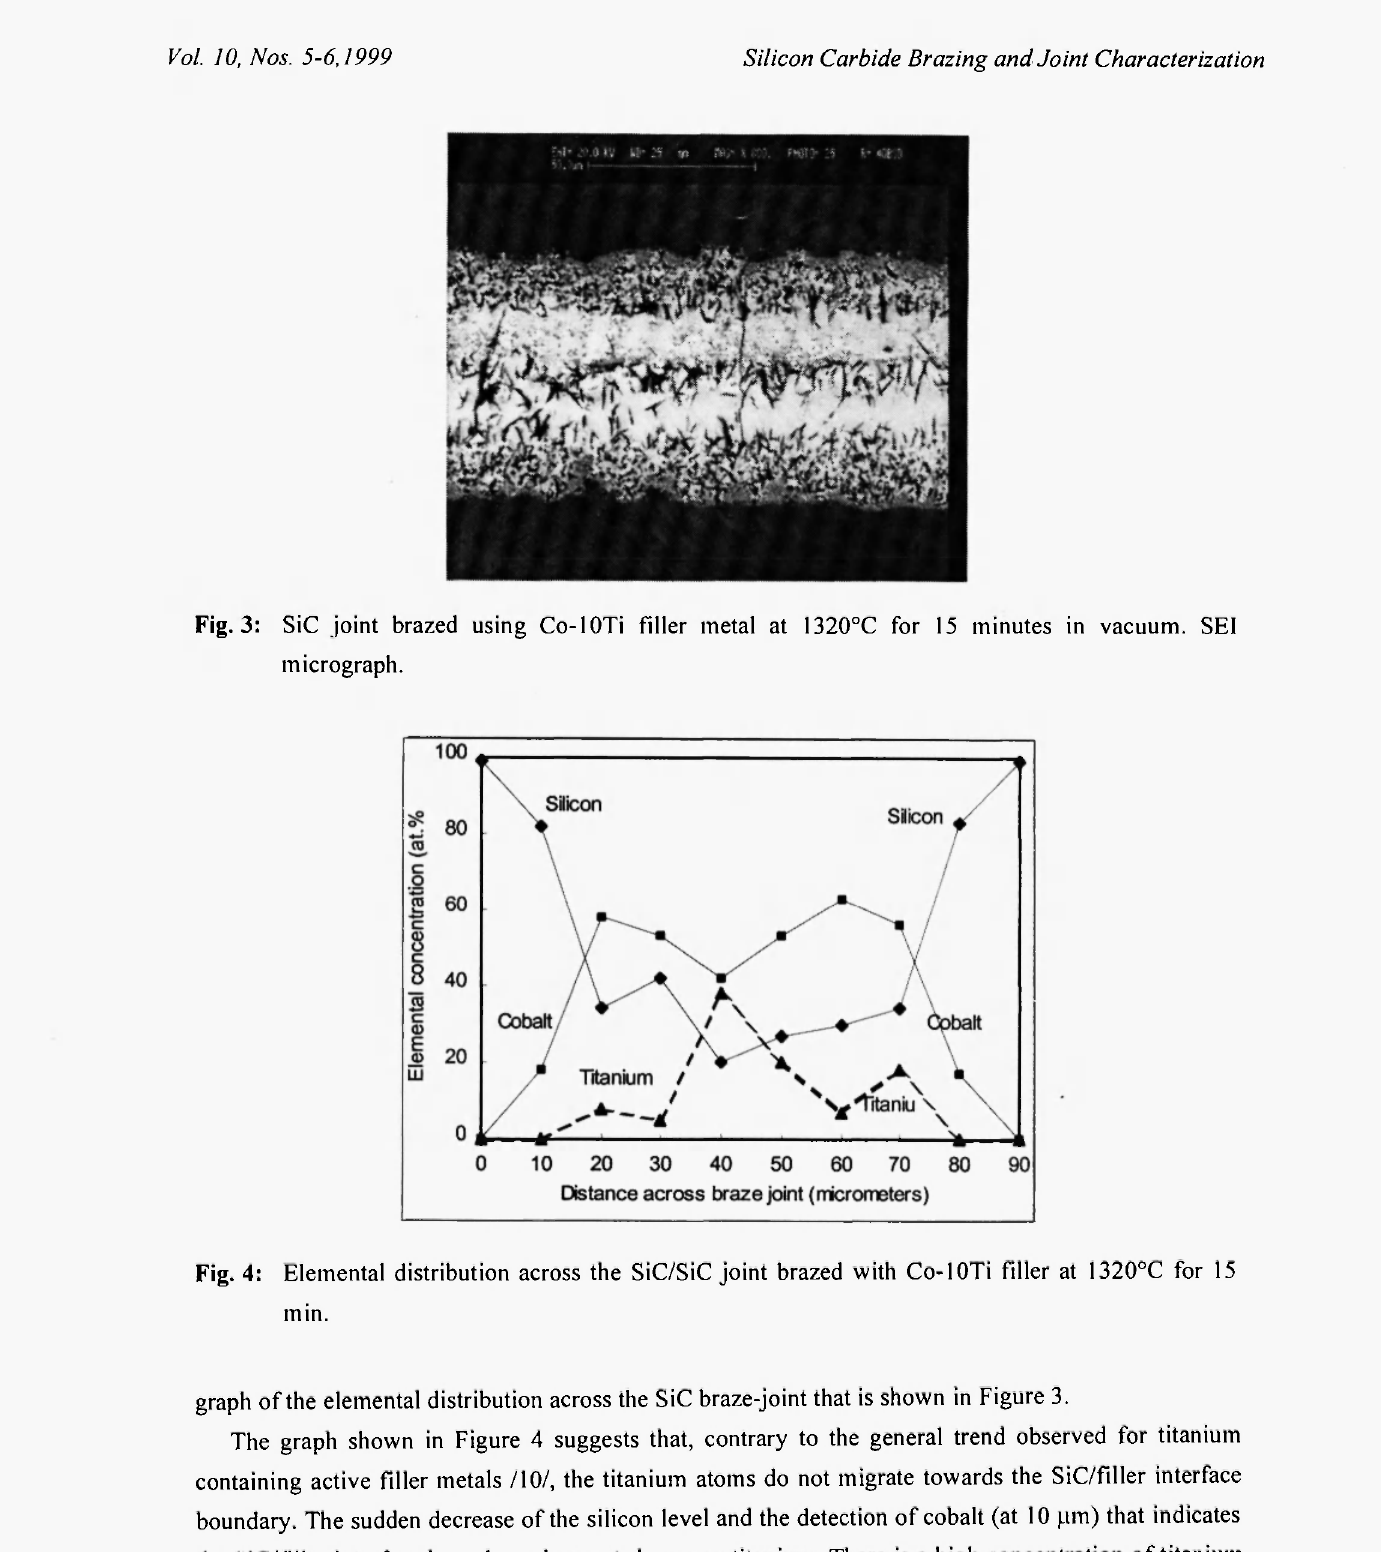
Fig. 4: Elemental distribution across the SiC/SiC joint brazed with Co-10Ti filler at 1320°C for 15